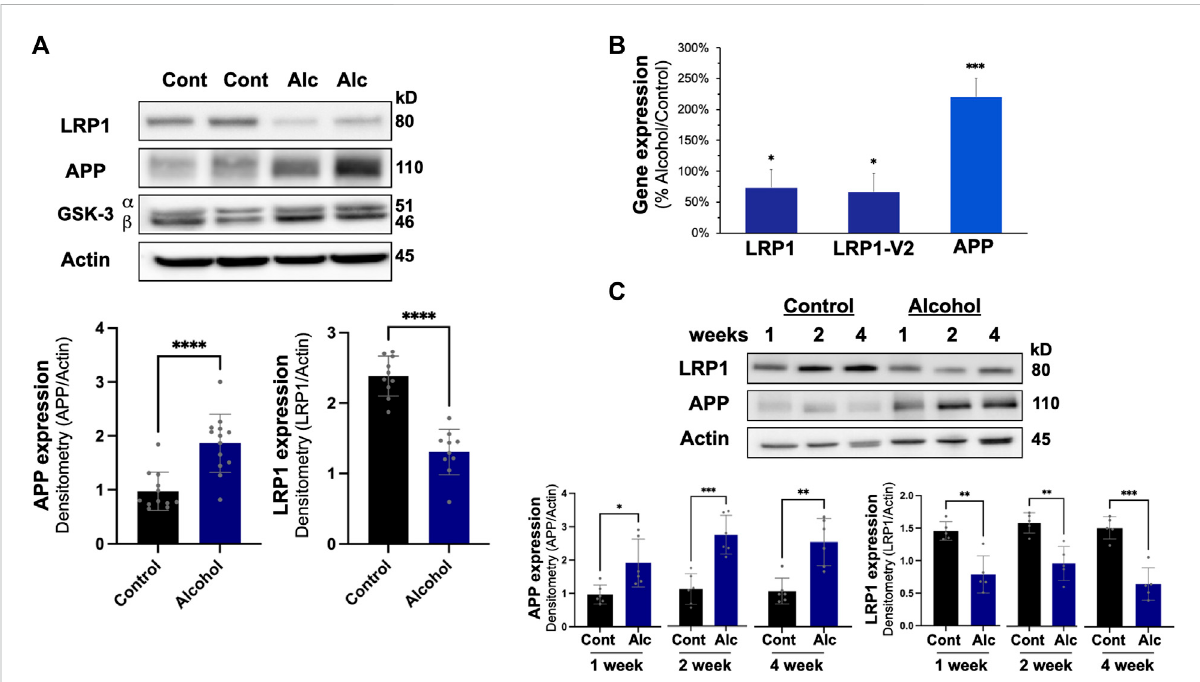
Effect of intragastric alcohol feeding on AD-relevant alterations in the liver of mice. (A) Expression of APP, LRP1, and other key proteins important in A β synthesis and transport in the liver following 4 weeks of intragastric alcohol feeding to mice. (B) Expression of LRP1 and APP mRNA following4 weeksofintragastricalcoholfeeding.LRP1andLRP2-V2representtwodifferentprimervariantsthatwereexaminedbyqPCRusingSYBR Green. β -actin was used as control, as it appeared most stable compared to other control genes examined. Data represents the mean ± standard error, with n = 11 – 18 mice. Percent changes are calculated with 2 − ΔΔ CT . (C) Time course of LRP1 down regulation and APP up regulation in theliverfollowingintragastricalcohol.Micewerefedalcoholintragastricallyfor1,2,and4 weeks.Allimmunoblotsshownarerepresentativesamples from four to six experiments. Densitometry for APP and LRP1 in the liver was performed using NIH Image J with β -actin being used as the loading control. Results are mean ± SD. n = 7 – 10 mice. **** p < 0.0001, *** p < 0.001, ** p < 0.01, or * p < 0.05 vs. control.